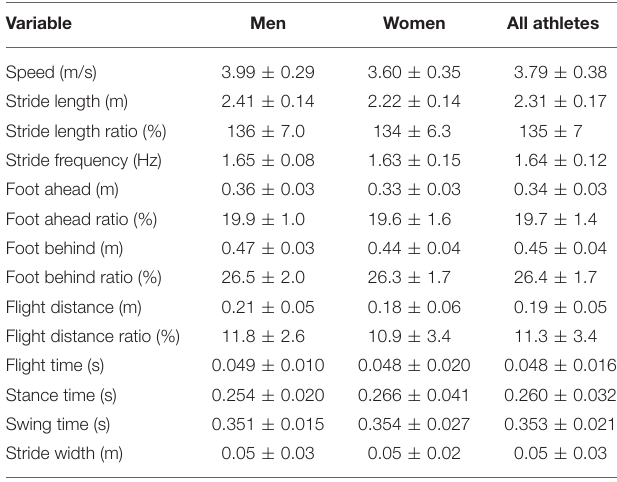
TABLE 2 | Group mean ± SD data for spatiotemporal variables for men, women, and all athletes (combined